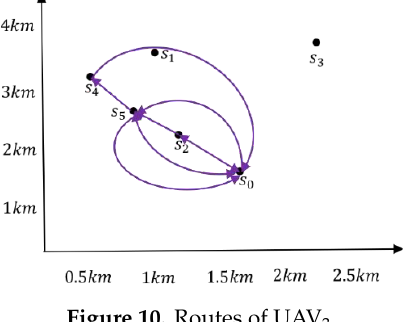
Figure 10. Routes of UAV 3 .